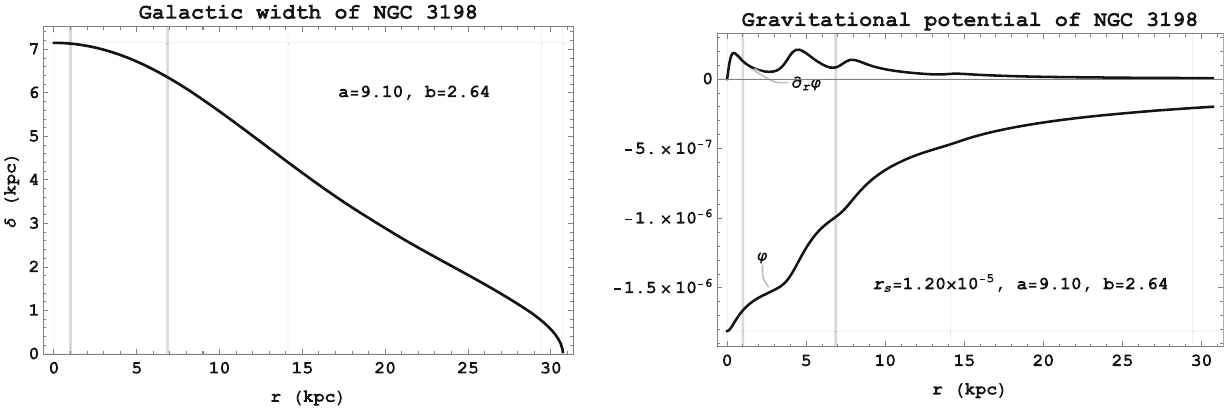
graphics correspond to the effective half-radius r eff = 1 . 00 kpc and to the transition position r 0 = 6 . 87